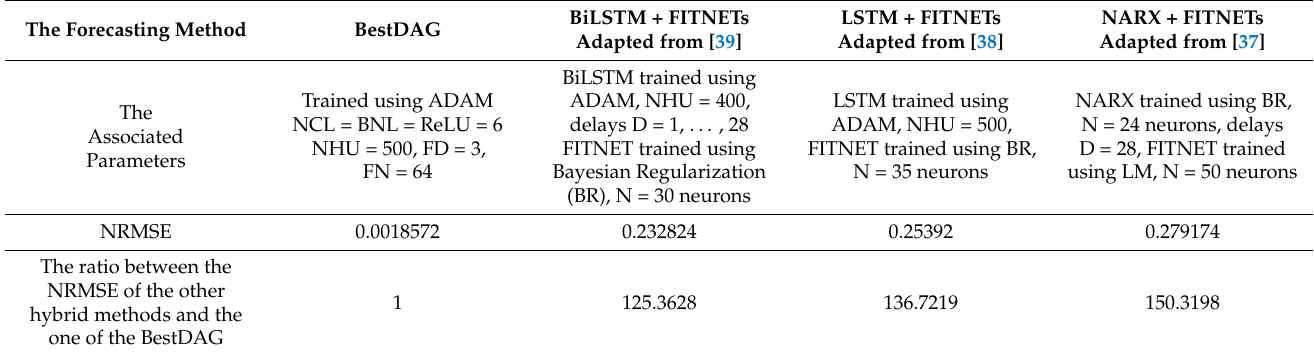
Table 5. A summary of the comparison of the BestDAG with other hybrid methods’ forecasting